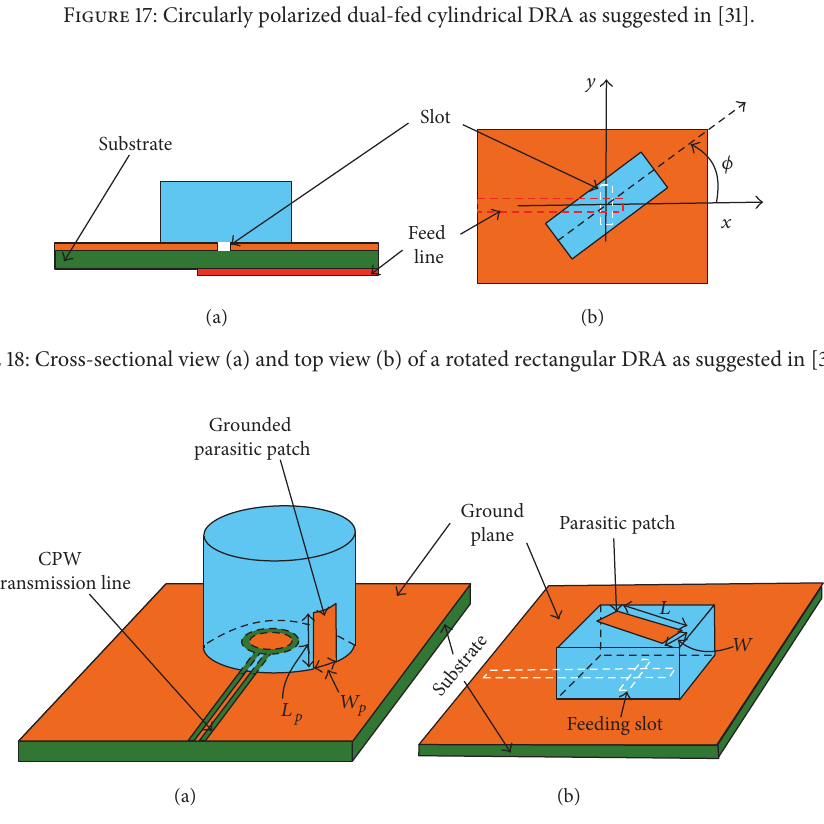
Figure 19: Three-dimensional view of a cylindrical DRA with a grounded parasitic patch (a) as introduced in [40] and three-dimensional view of a rectangular DRA with a parasitic patch placed on its top face (b) as presented in